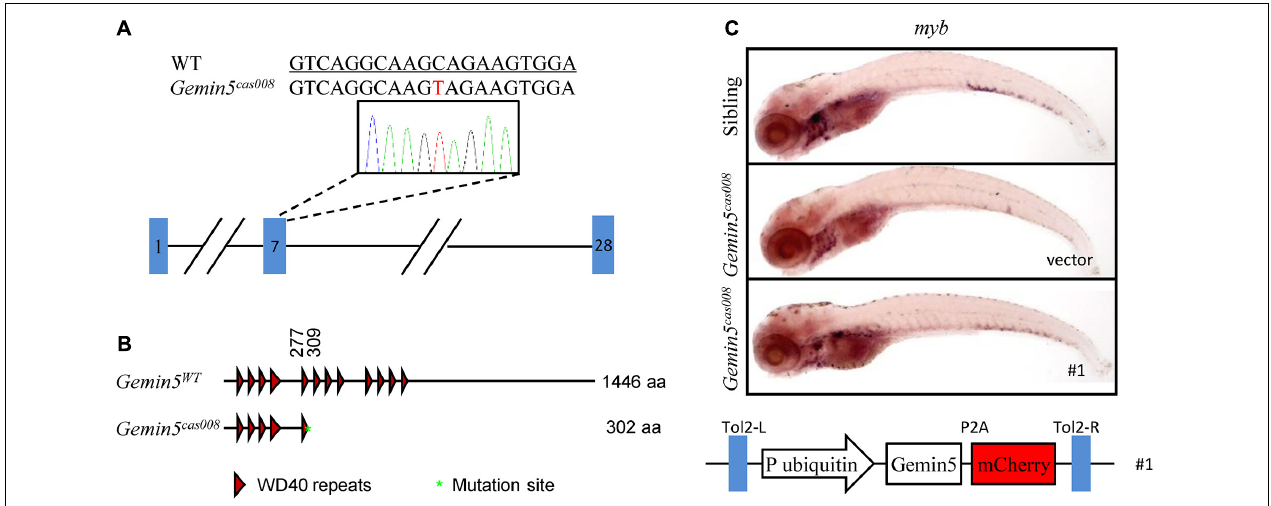
FIGURE 2 | The mutation was mapped to a point mutation in gene gemin5 . (A) The alignment of WT (underlined) and NC_007132.7: g.36404684 C > T ( gemin5 008 ) sequences are listed. The mutation by ENU is indicated in red (a C to T nonsense mutation causes an immediate stop codon in gemin5 in mutant cas 008 ). (B) According to the stop codon in the genome, SMART software was used to predict the structure of Gemin5 WT and XP_001339880.4:p.Gln303_His1440del (Gemin5 008 ) presumed protein. The molecular sizes of the presumed protein are indicated on the right. (C) WISH analysis with myb probe in the CHT region (at 6 dpf) of sibling and gemin5 008 with transient transgenesis of vector (only plasmid backbone) or ubi: gemin5 (#1, The construction of the plasmid is shown